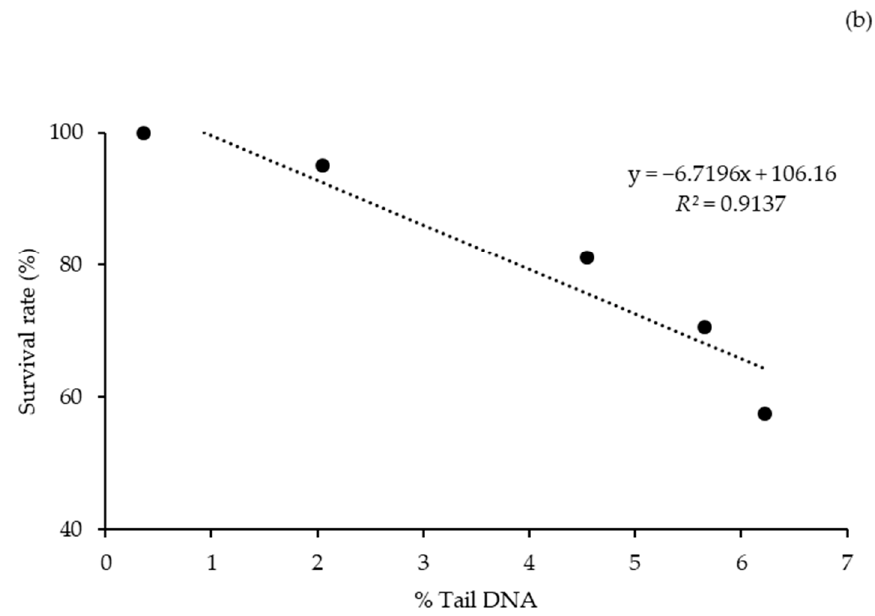
Figure 6. Correlation between MSR and survival rate to percentage of Tail DNA (x) in frozen–thawed sperm: ( a ) relationships between MSR and % Tail DNA; ( b ) relationships between survival rate and % Tail DNA. R 2 = Pearson’s correlation coefficient.